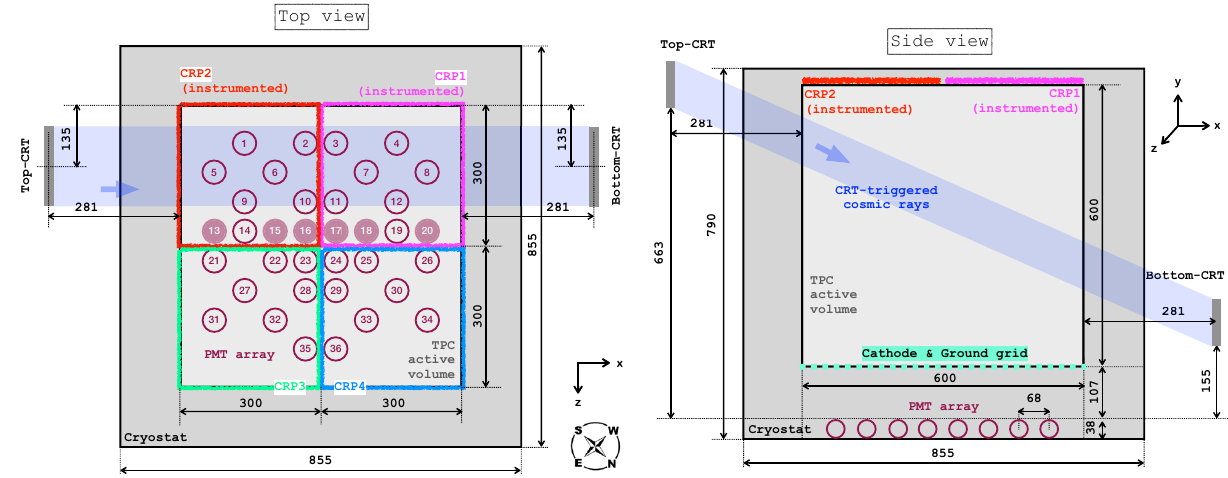
Fig. 1 Views of ProtoDUNE-DP. Dimensions and positions of the major elements are indicated (in units of centimeters). The drift direction corresponds to the y -axis. The PMTs are represented with circles and, in the top view, the empty circles correspond to PEN PMTs and the filled circles to TPB